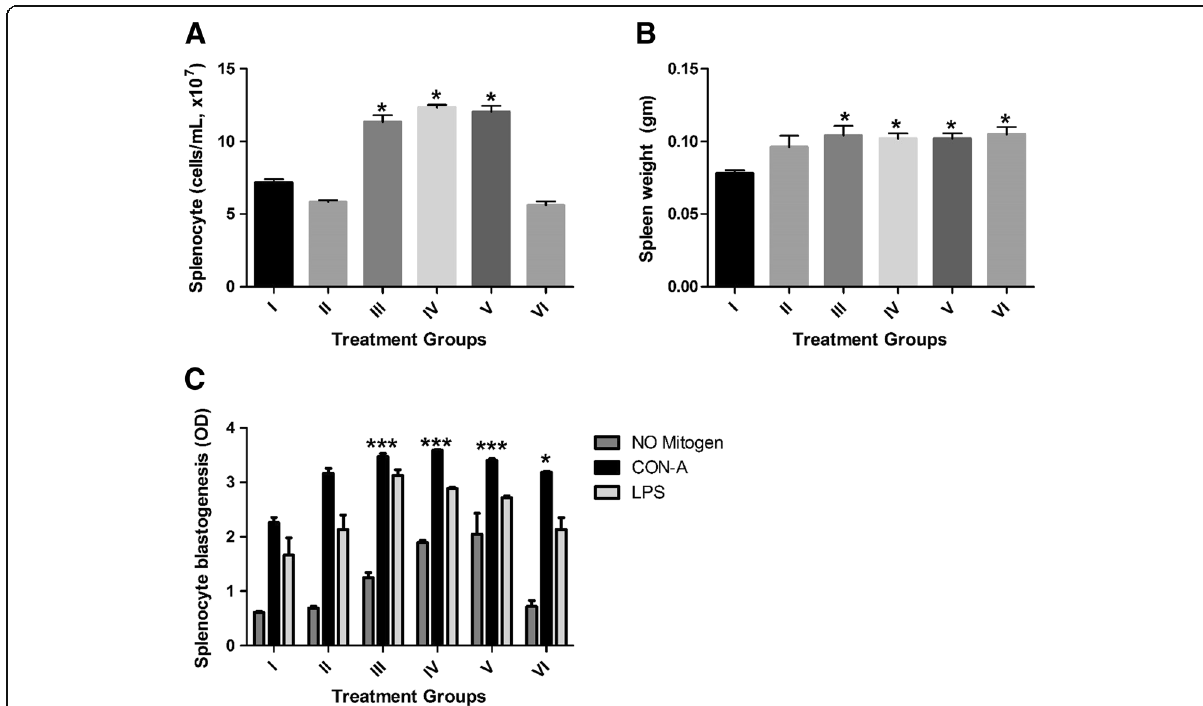
Fig. 2 Effect of Denropanax morbifera on the splenocytes of mice. a Total splenocyte count of different treatment groups. A significant increase in splenocyte counts was observed in mice among control groups and those that received ginseng extract or 125 and 250 mg/kg of D. morbifera Léveille. b Weight of spleen taken from each mouse group. c In vivo activation of splenocytes by Con A and LPS after 72 h of incubation. A significant difference was observed between group II and group III, as well as groups V and V treated with Con-A and LPS (* P value <0.05; *** P